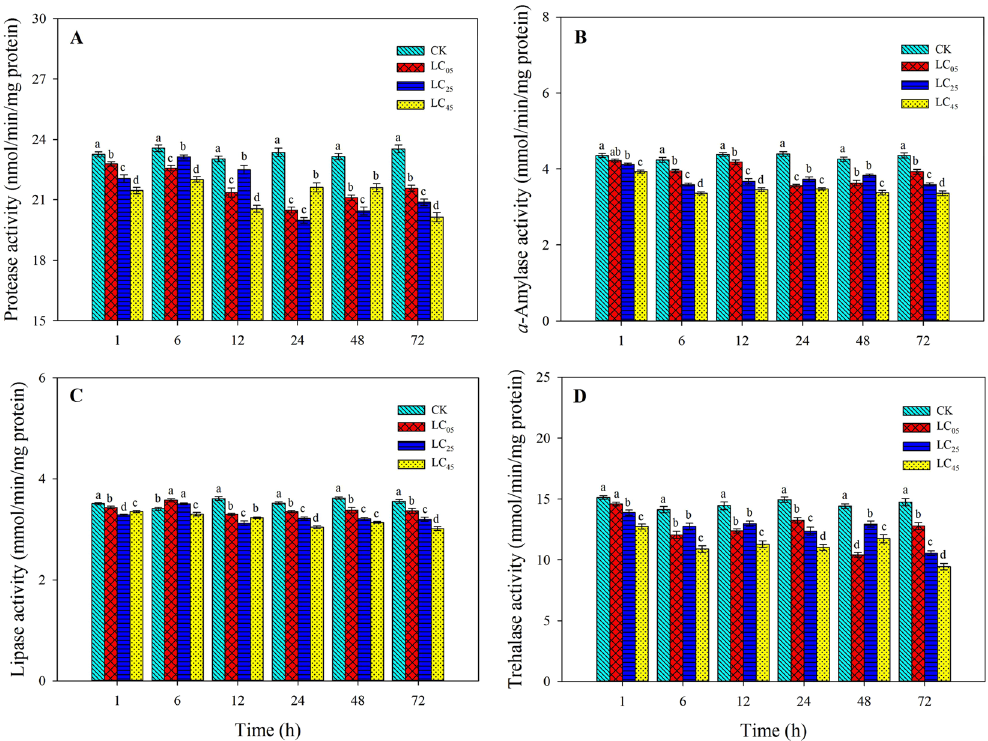
Figure 7. Digestive enzyme activities ( A ) protease, ( B ) α -amylase, ( C ) lipase, ( D ) trehalose) in A. ipsilon larvae (mean ± SE) after exposure to low-lethal doses of chlorantraniliprole. Bar with the same lowercase letters show no significant differences (Student-Newman-Keuls test, P <